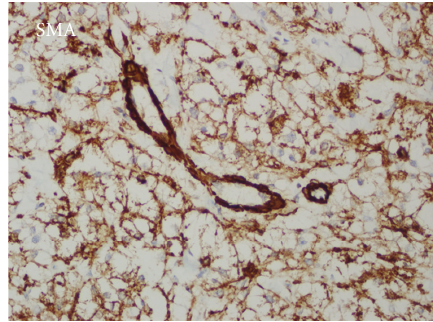
Figure 3: SMA positivity in perivascular tumor cells.